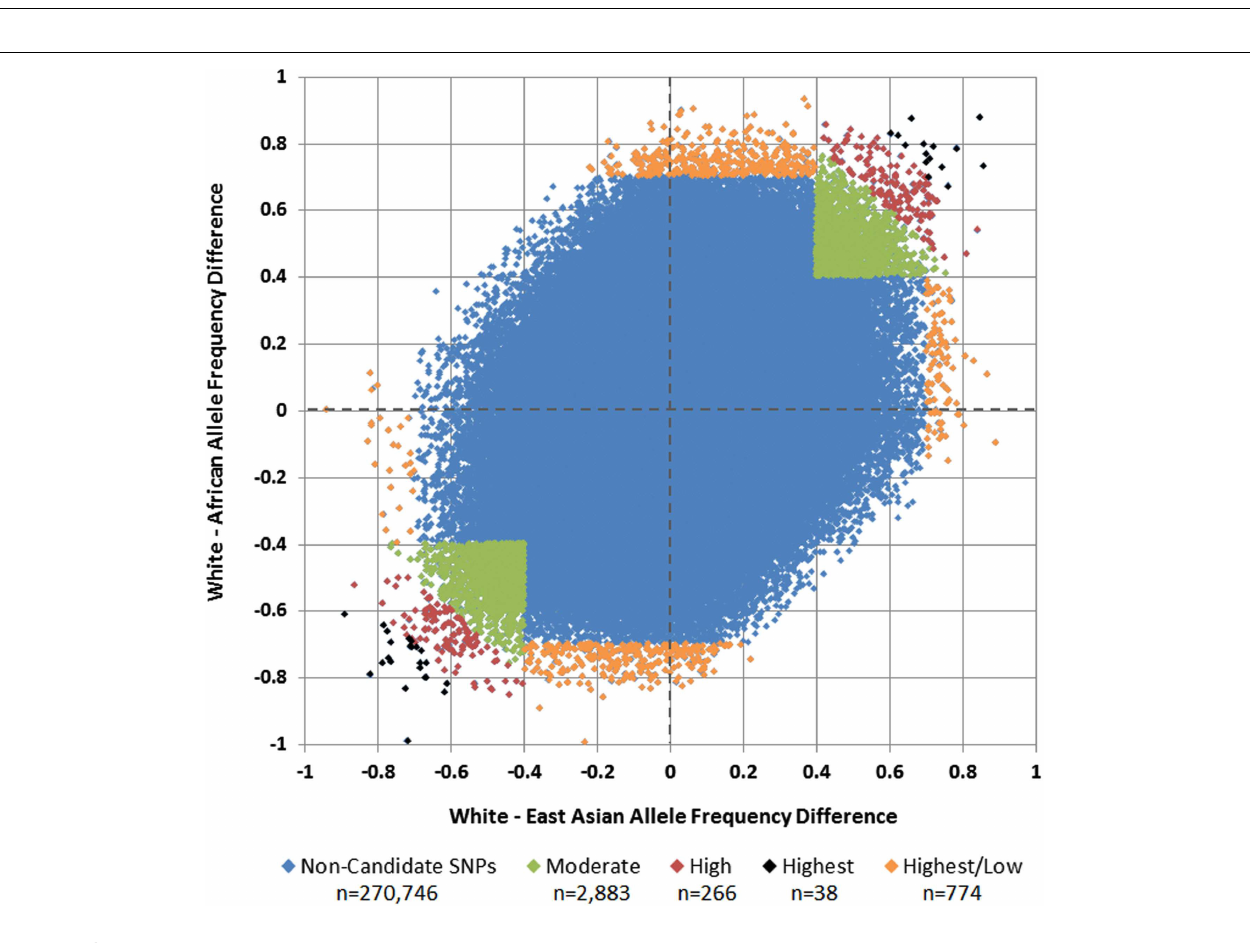
FIGURE 3 |White vs.African andWhite vs. EastAsian allele frequency differences and selected candidate SNPs. Each SNP is plotted by its allele frequency difference betweenWhites and Africans vs. its allele frequency difference betweenWhites and East Asians. Green SNPs in the upper-right and lower-left quadrants represent those with mean allele frequency differences of